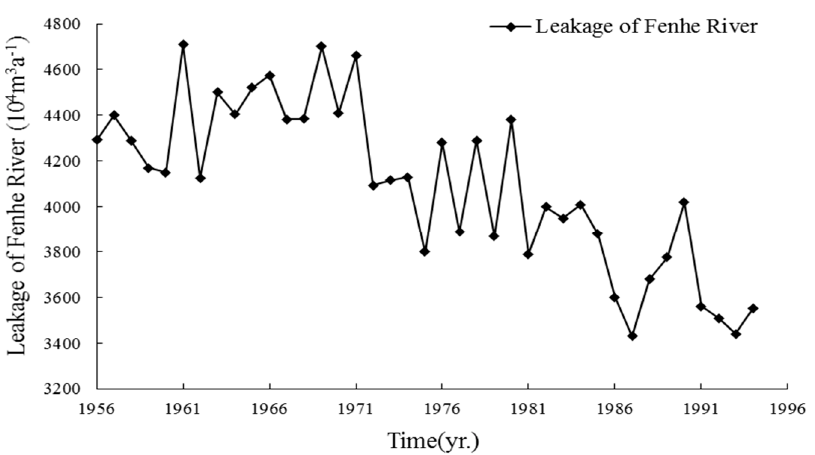
Figure 7. Leakage of Fenhe River.